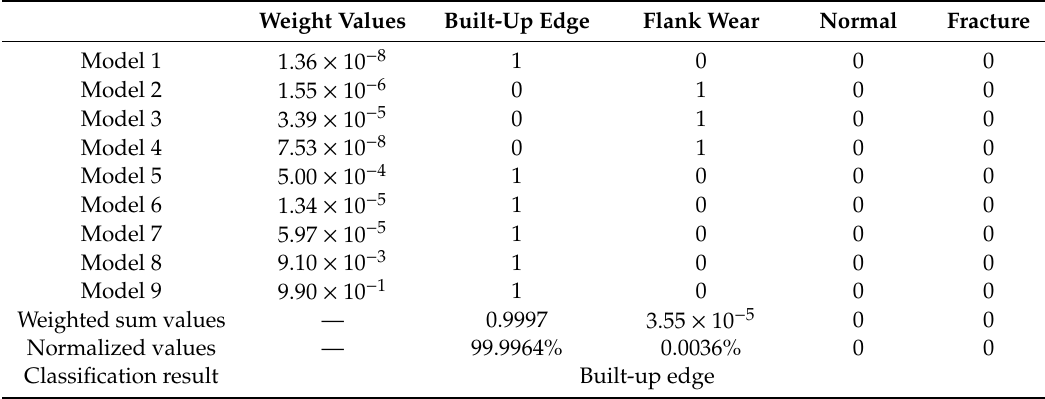
Table 7. Insert condition classification results. (cutting speed 318 m / min, depth of cut 1.8 mm, cutting feed 0.19 mm /